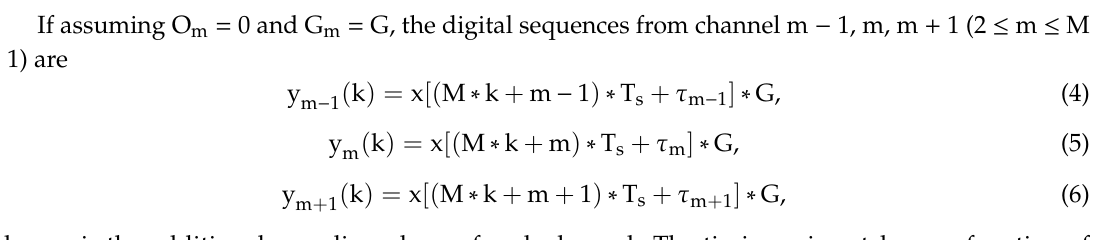
Figure 2. Overall block diagram of automatic wideband timing-mismatch detection.